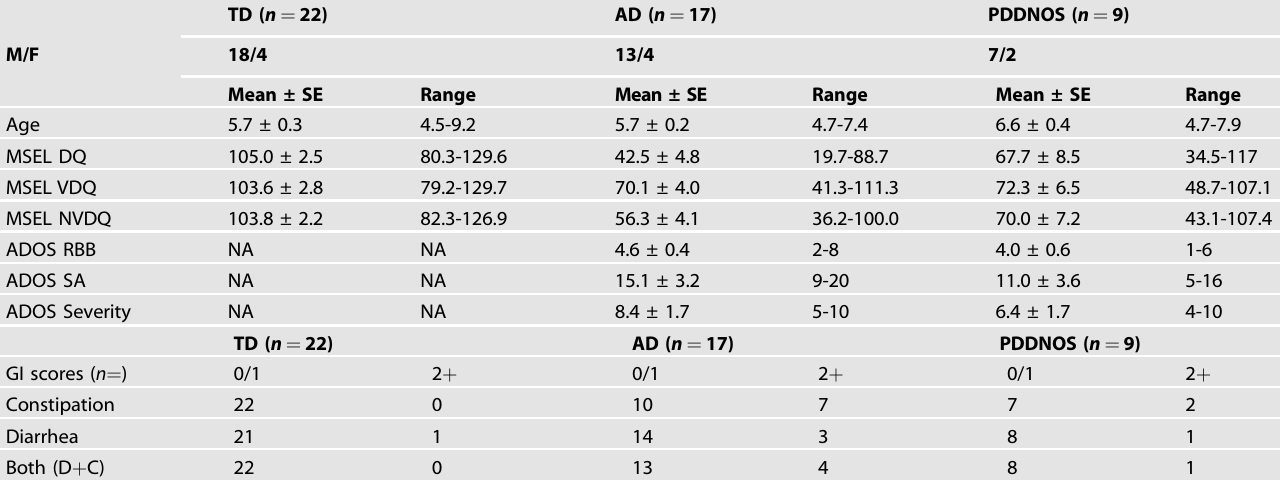
Table 1. Clinical characteristics and demographics of study